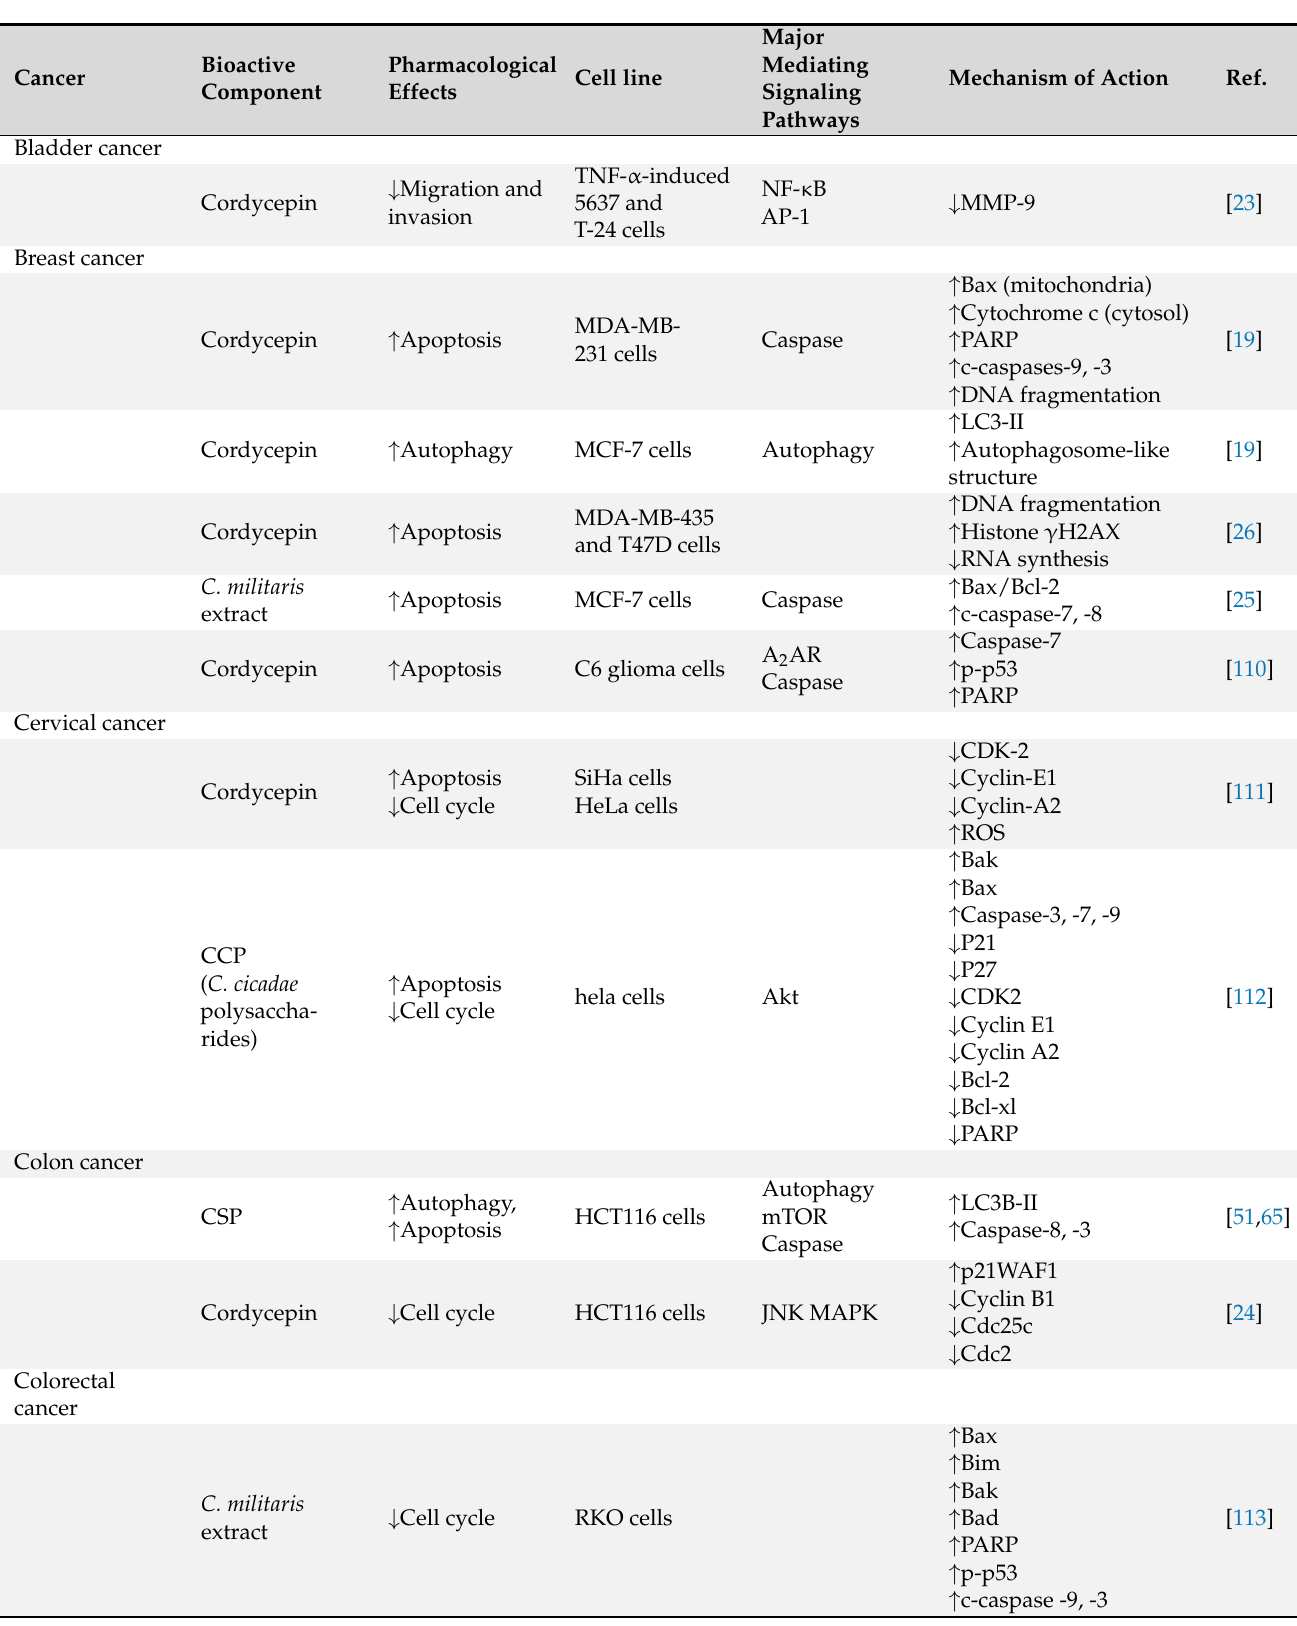
Table 4. Antitumor effects and mechanisms of Chinese Cordyceps in various cancer